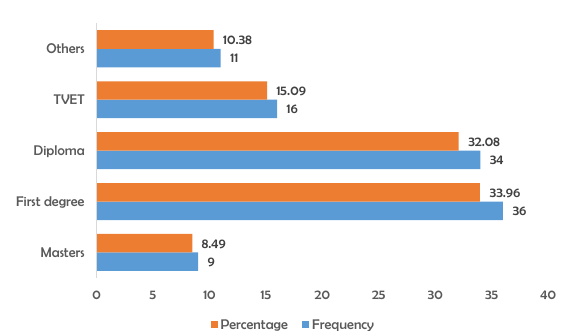
Fig. 1 Educational background of the respondents. Frequency and percentage of respondents ’ educational background.